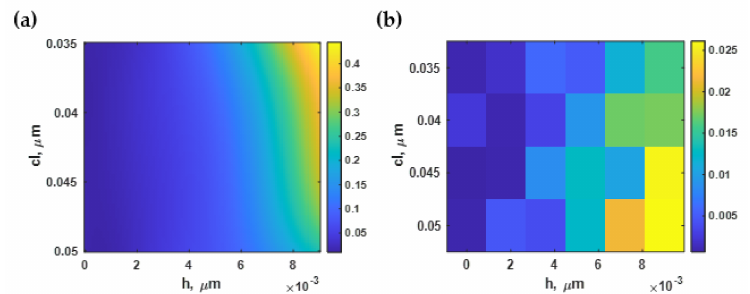
Figure 15. ( a ) The normalized dip intensity using Equation (11); and ( b ) the difference between Equation (11) and the simulated output.